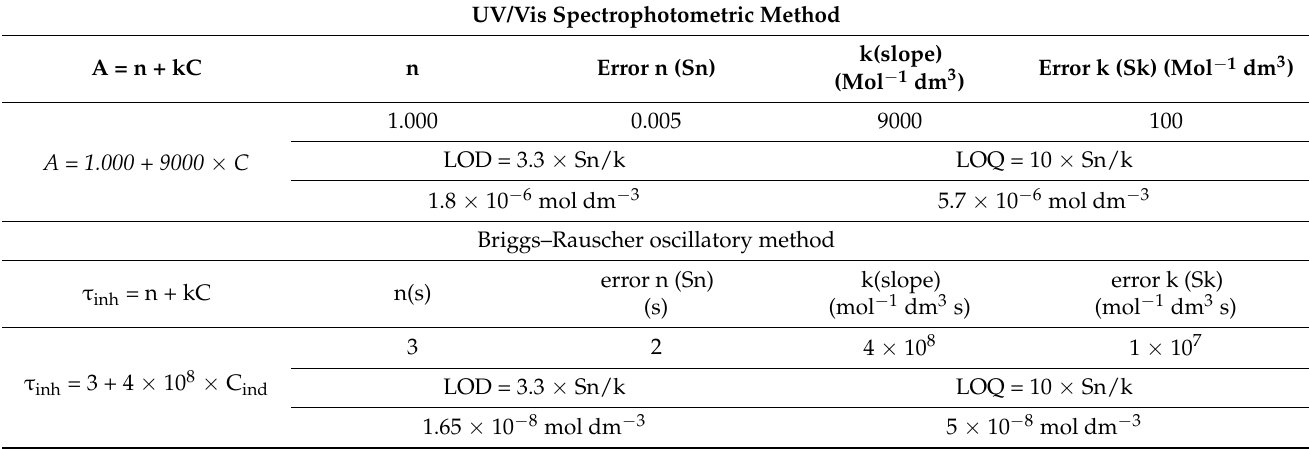
Table 2. A comparison of the two different methods used to determine indigo carmine concentration in the food dye